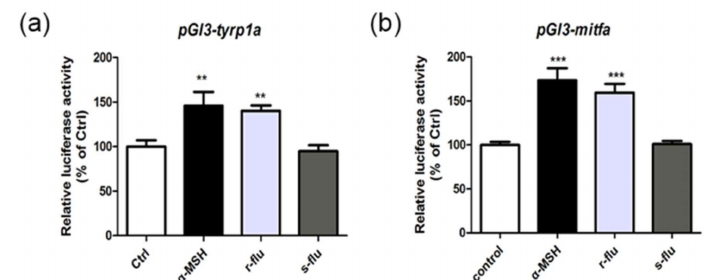
Figure 4. B16F10 cells were transfected with luciferase reporter constructs and treated with the r/s-fluoxetine 10 µ M for 24 h. ( a ) pGL3-tyrp1a and ( b ) pGL3-mitfa. Results shown are means ± SEM and representative of three independent experiments. Data were analyzed by ANOVA, followed by a post hoc Tukey test. Bars indicate the means ± SEM of the three independent experiments. ** p < 0.01, *** p < 0.001, compared with the control